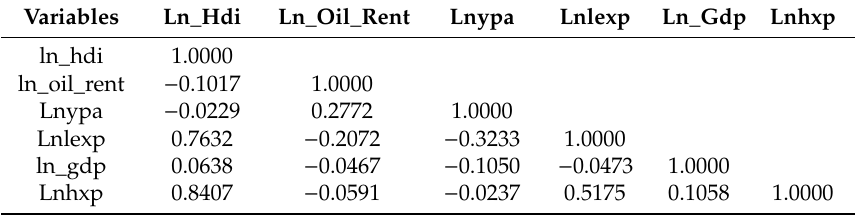
Table 4. Correlation analysis.